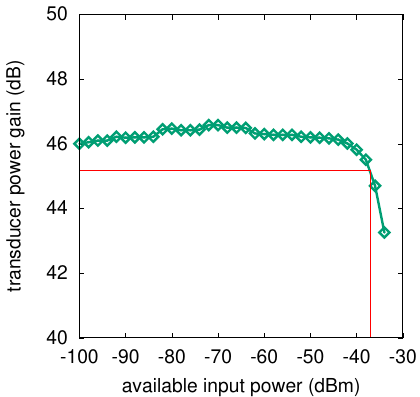
Figure 9. Linearity. Measured large signal receiver gain versus the available input power at 28.65GHz. The input-referred 1 dB compression point is P 1 dB = − 37dBm. This value includes the 1.5dB insertion loss due to the coaxial-to-CPW end launcher and input feeding line.